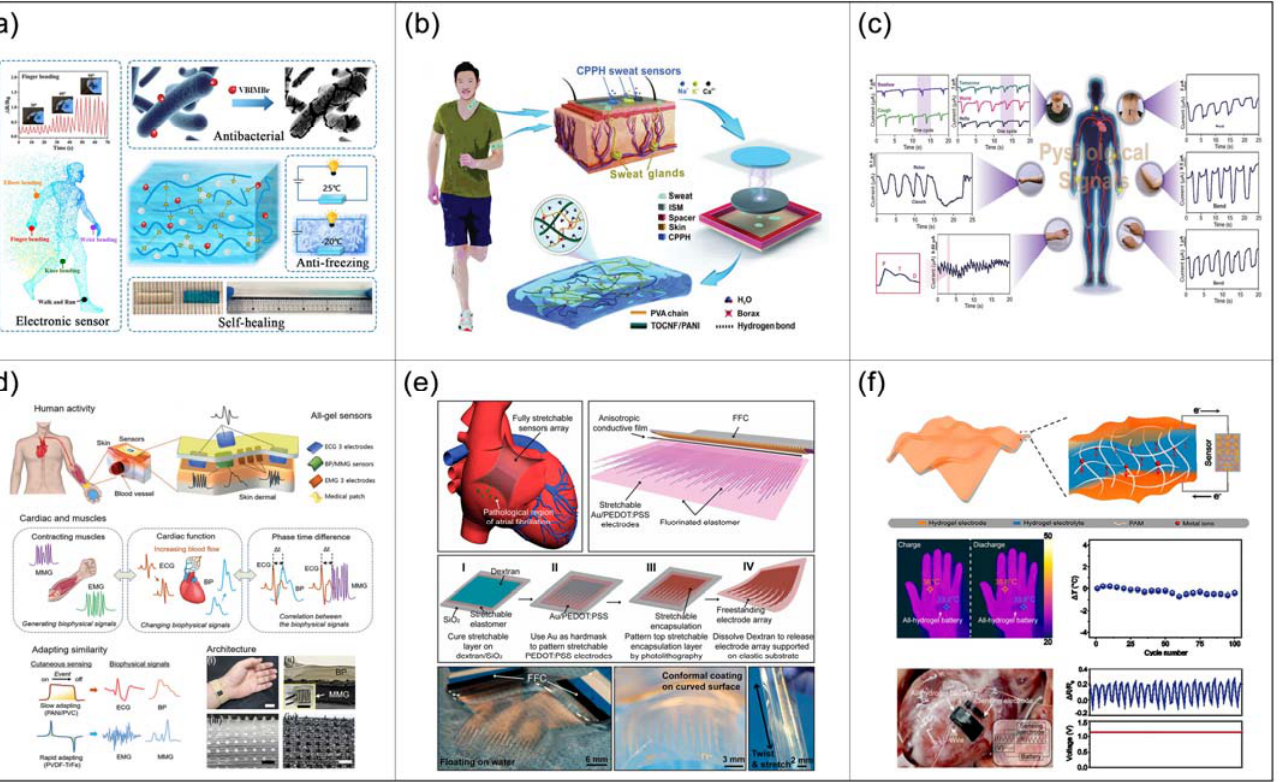
Figure 3. Applications of CHs in biosensors. ( a ) Principle and application of a novel ionic liquid segmental polyelectrolyte CHs. ( b ) Cellulose-based conductive hydrogel is used for self-powered sweat sensing. ( c ) Physiological data health monitoring of different parts by electronic skin. ( d ) Schematic diagram of the artificial skin sensor system and heart-related biophysical signals. ( e ) Fabrication and assembly of elastomeric arrays for cardiac health monitoring. ( f ) Schematic illustration of the structure and working mechanism of the all-hydrogel battery; application of the all-hydrogel batteries.